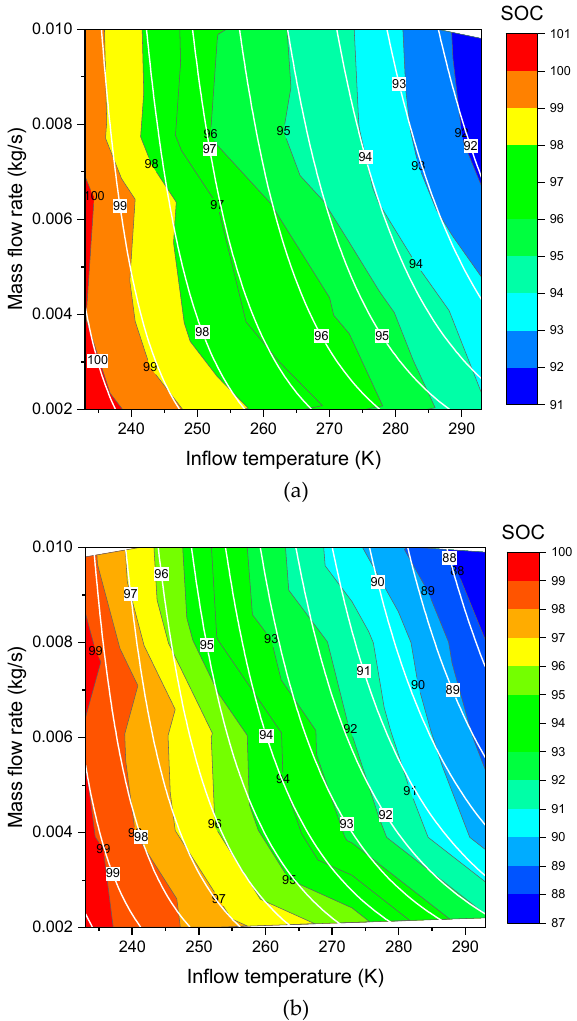
Figure 3. Contours of SOC over inflow temperature (X) and mass flow rate (Y) for ( a ) Type III tank and ( b ) Type IV tank (Color fill and black line: data [14], white line: model fitting).